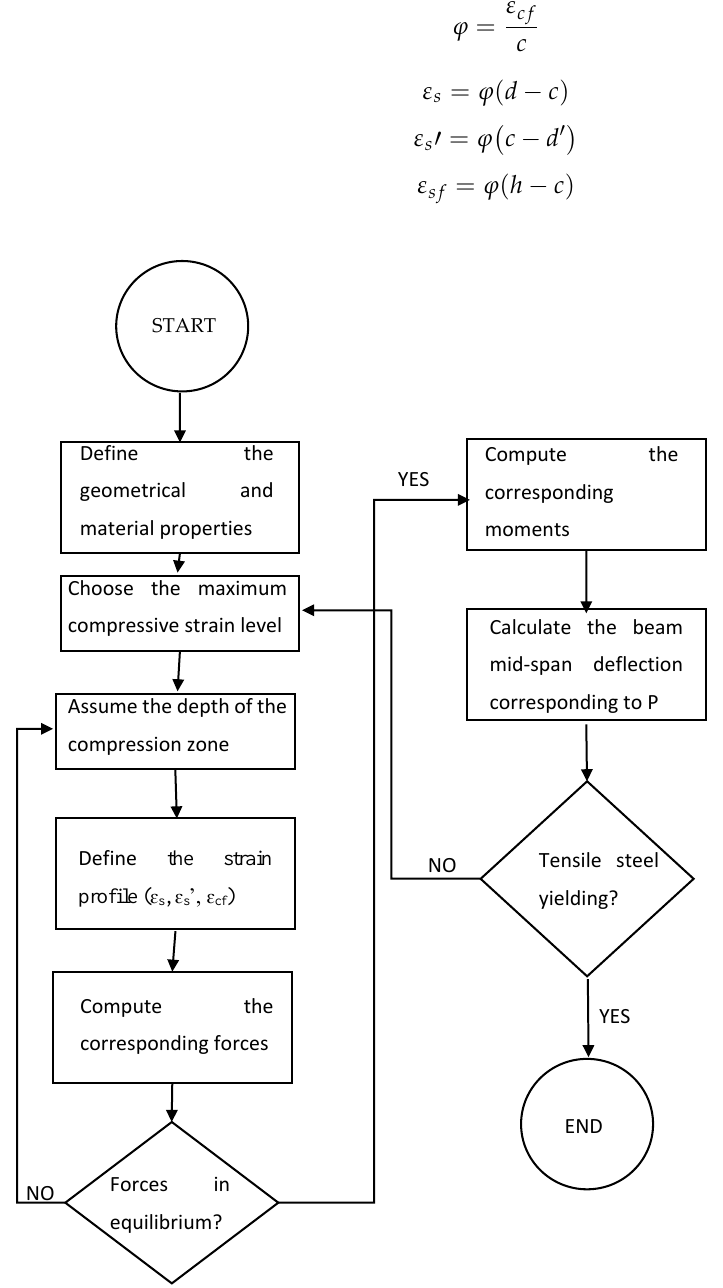
Figure 6. Flexural analysis flowchart up to yielding point.